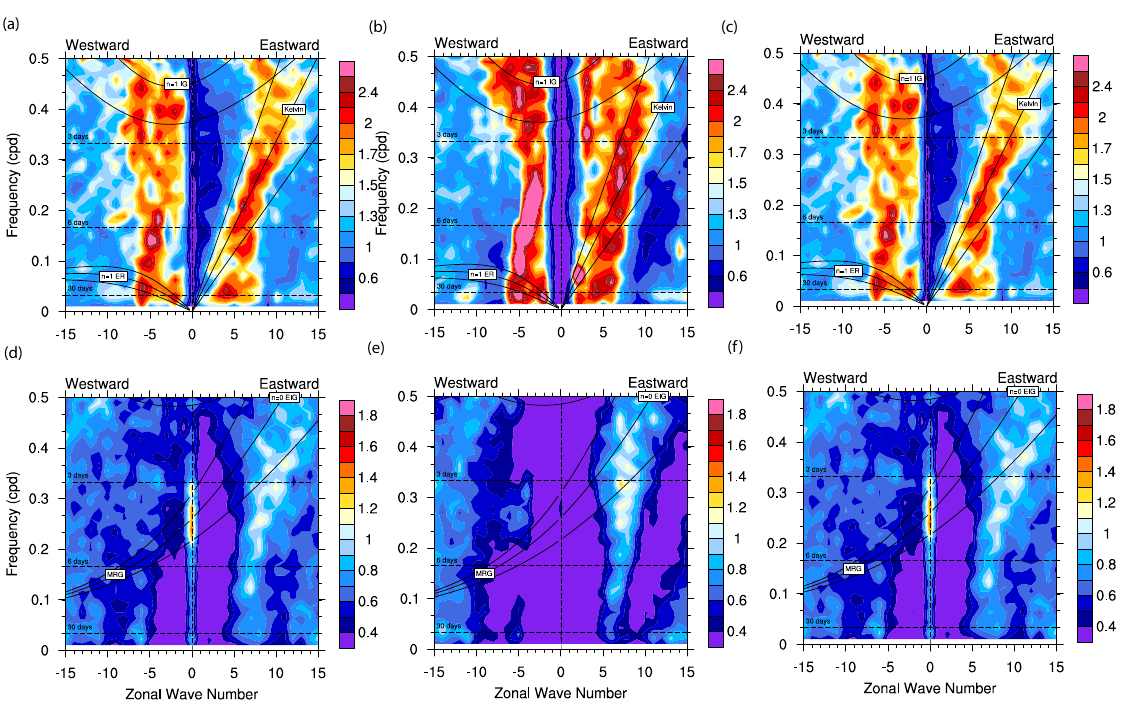
Figure 8. Wavenumber-frequency spectrum of the 200 hPa zonal wind field associated with the westward inertio-gravity modes. Panels ( a – c ) refer to the symmetric part, while panels ( d – f ) refer to the antisymmetric part. The full spectrum of vertical modes is presented in panels ( a , d ), the barotropic component of the corresponding parts is displayed in panels ( b , e ), and the baroclinic component is illustrated in panels ( c , f